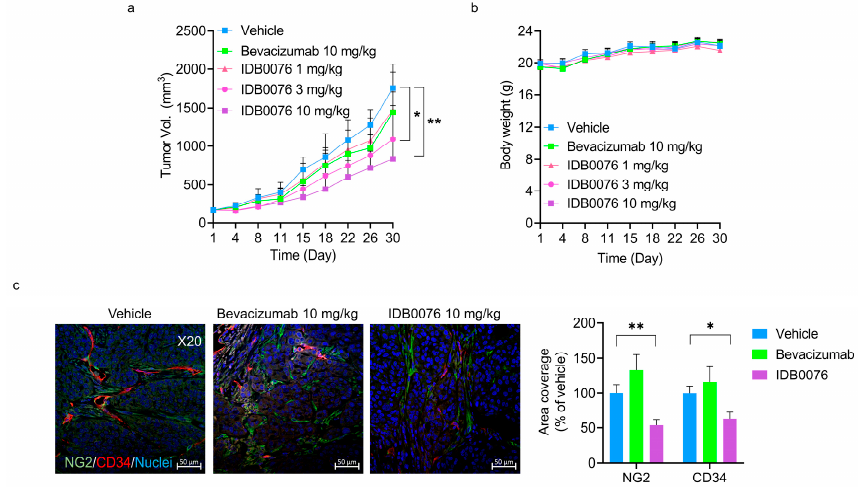
Figure 4. IDB0076 suppressed tumor growth and neovascularization in the BxPC-3 xenograft model in comparison with bevacizumab. Mice were inoculated subcutaneously into the right flank with 5 × 10 6 BxPC-3 cells. The mice bearing BxPC-3 cells were dosed with vehicle, IDB0076, or bevacizumab i.v. twice a week for 4 weeks. ( a , b ) Tumor growth and body weight were measured and monitored twice a week. Data are presented as mean ± SEM ( n = 7 per group). ( c ) Representative images of blood vessels stained for CD34 (red), NG2 (green), and nuclei (blue). The bars in the graph denote the quantification of blood vessel and pericyte coverage in comparison with vehicle as the mean ± SEM of 10 images per tumor ( n = 7 per group). Magnification: × 20, scale bar: 50 µ m; * p < 0.05, ** p < 0.01 as compared with the vehicle group.